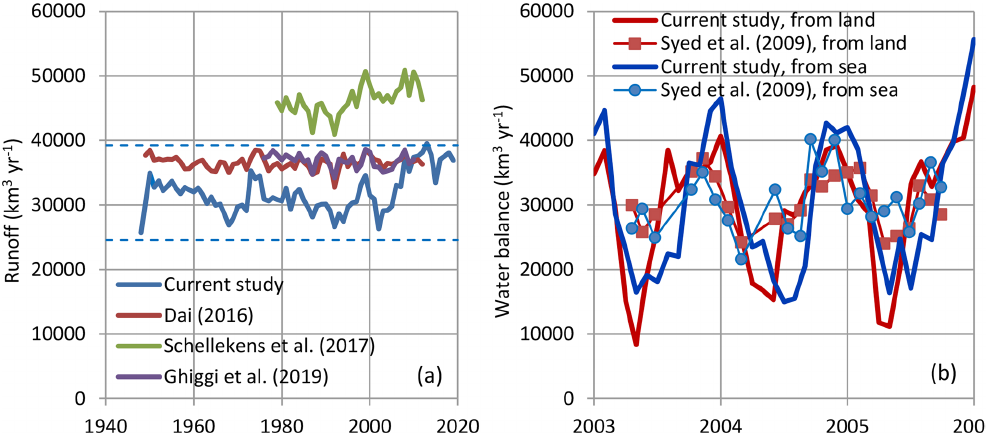
Figure 16. Comparison of the results of the current study for surface runoff with those of (a) Dai (2016; Fig. 2.8; digitized), Schellekens et al. (2017; Fig. 7; digitized; ensemble mean), Ghiggi et al. (2019; Fig. 8a; digitized; ensemble mean) at the annual scale and (b) Syed et al. (2009; Fig. 7; digitized) at the monthly scale (but with rates expressed in km 3 yr − 1 ). Dashed lines in (a) are the 95% confidence limits of the 30-year climatic average of the current